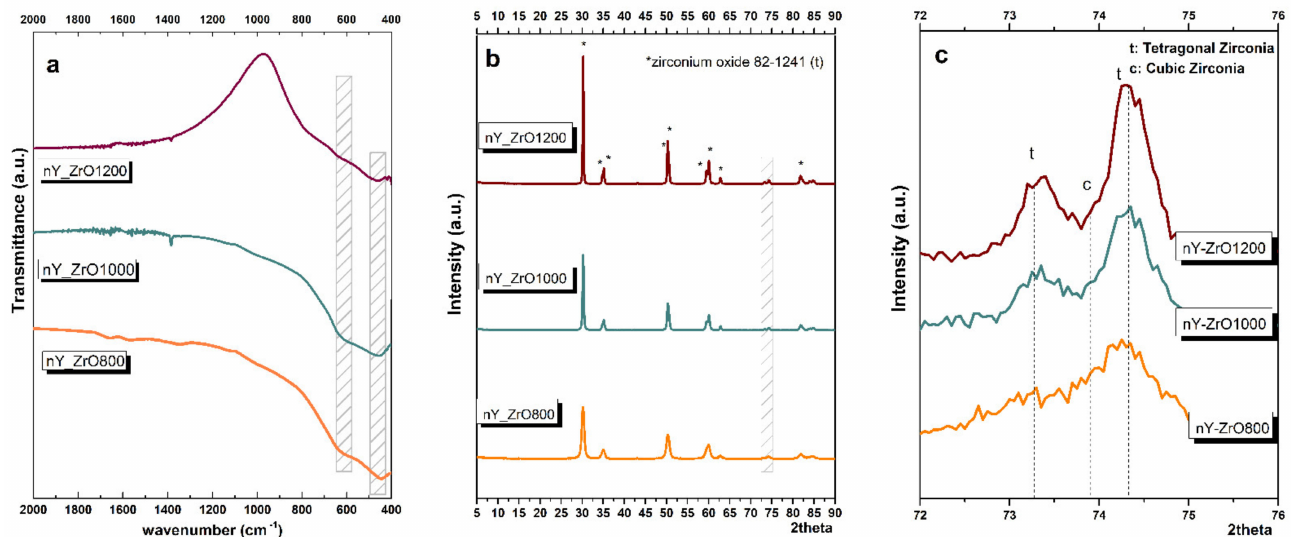
Figure 2. ( a ) FTIR; ( b ) XRD analysis of the zirconia nanoparticles sintered at 800, 1000 and 1200 ◦ C, respectively. Higher magnification of XRD patterns in the area of 72–76 2 θ is presented in ( c ) to unravel the splitting of the peaks due to the presence of the tetragonal phase.